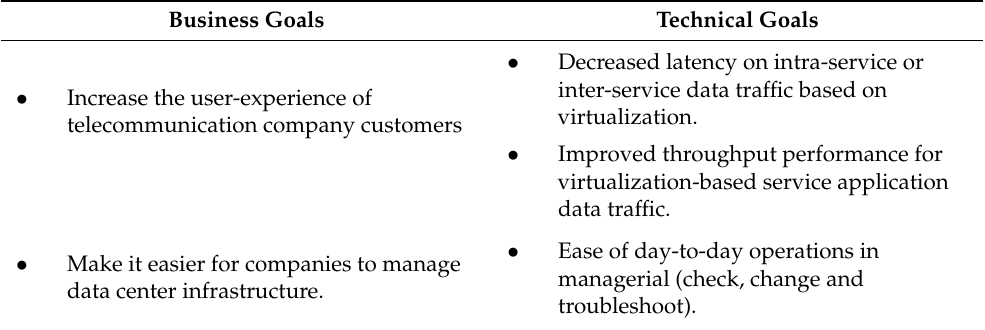
Table 2. Technical Goals to Business Goals Mapping.